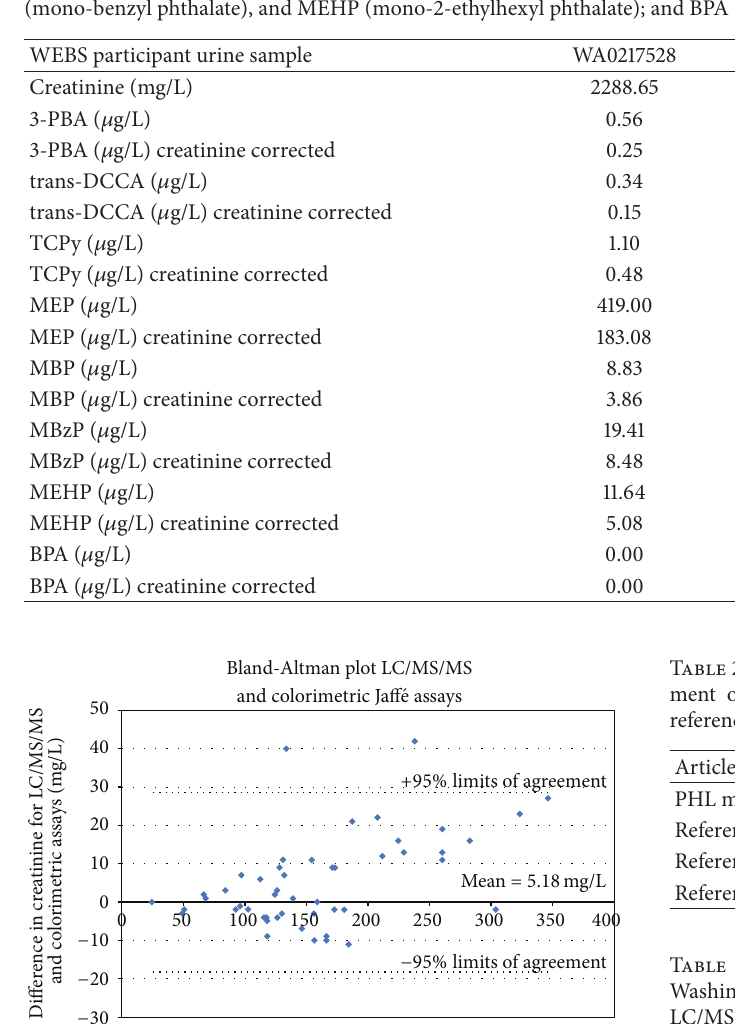
Table 1: Selected WEBS urine samples showing creatinine corrected results and noncorrected results for selected pyrethroid pesticide metabolites: 3-PBA (3-phenoxybenzoic acid) and trans-DCCA (trans-3-(2,2-dichlorovinyl)-2,2-dimethylcyclopropane-1-carboxylic acid);